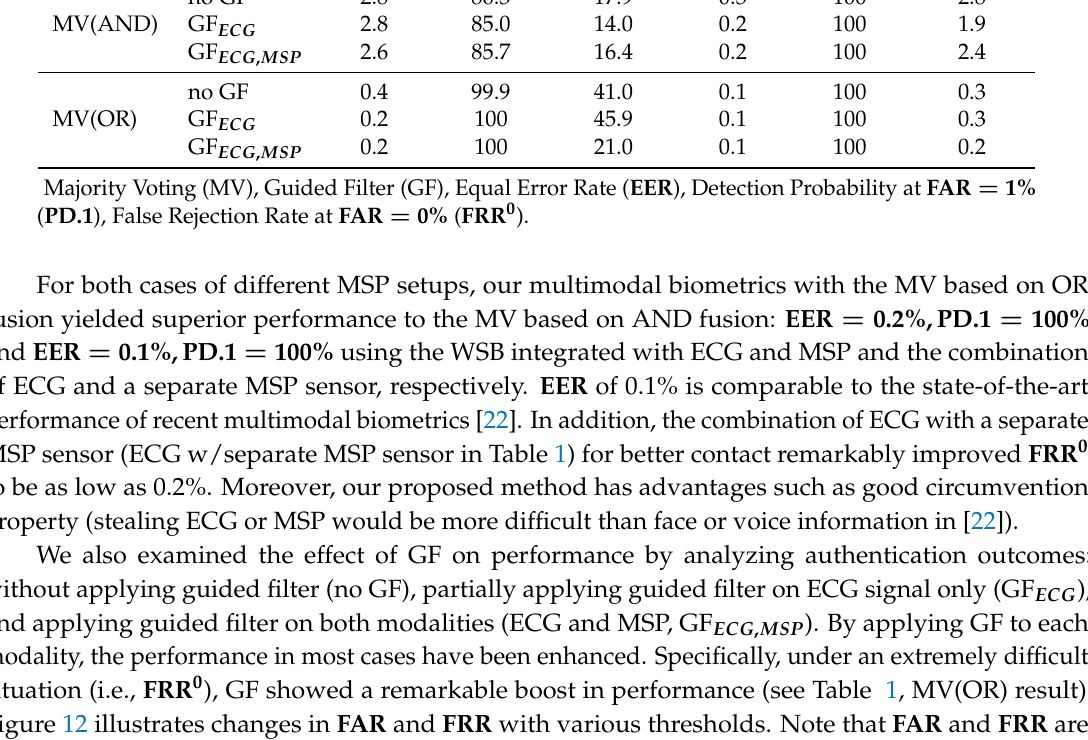
Performance summary for multimodal biometric authentication results using Electrocardiogram (ECG) and Multispectral Skin Photomatrix (MSP). Modality ECG + MSP Integrated in WSB ECG + Separate MSP Sensor EER [%] PD.1